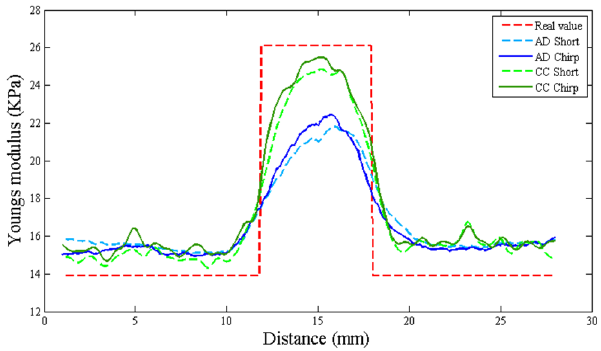
Figure 27. Young’s modulus of phantom including hard substance for two pulses by two algorithms.